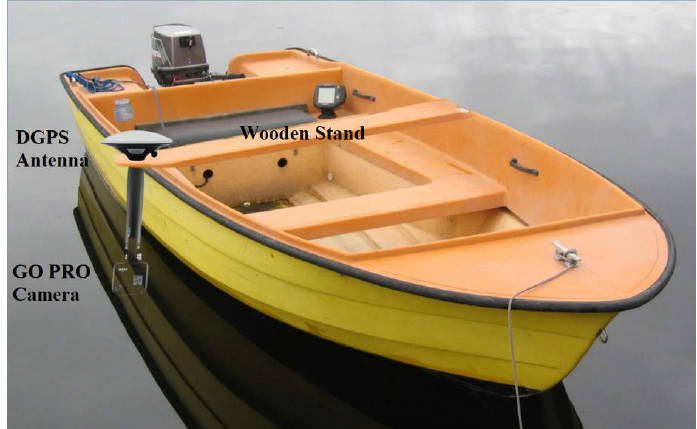
Figure 2. The attached GO PRO camera and differential global positioning system (DGPS) antenna on the motorboat.